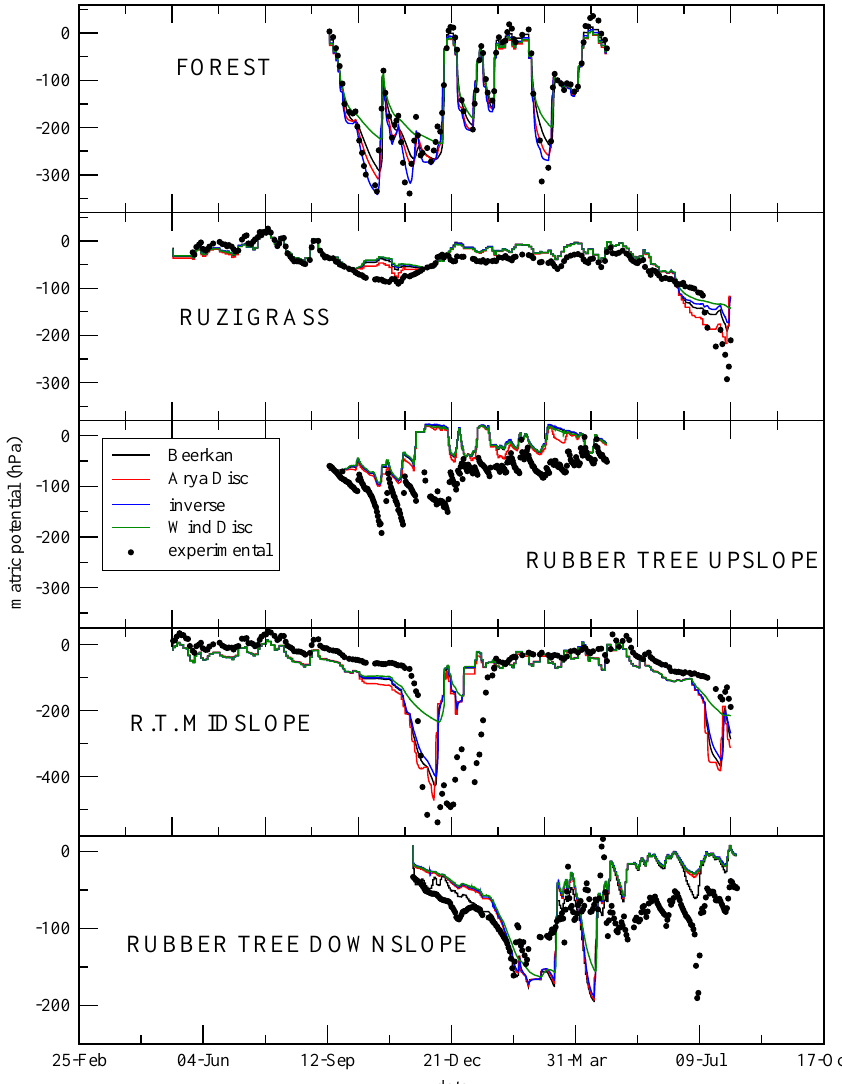
Figure 4. Development of the matric potential at 0.25m depth in the different locations (black dots) and results of modeling with Hydrus1D (continuous